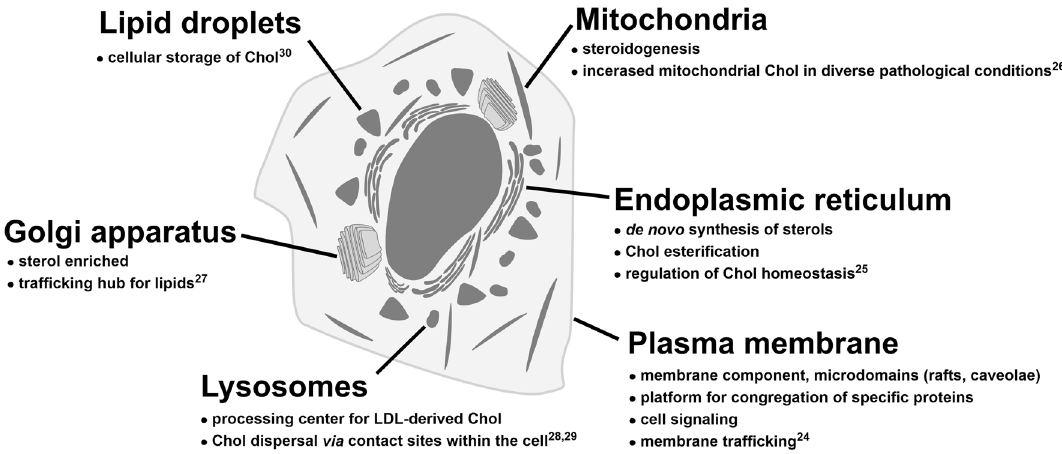
Figure 1. Compartmentalization of cellular cholesterol and its important functions with references to literature 24–30